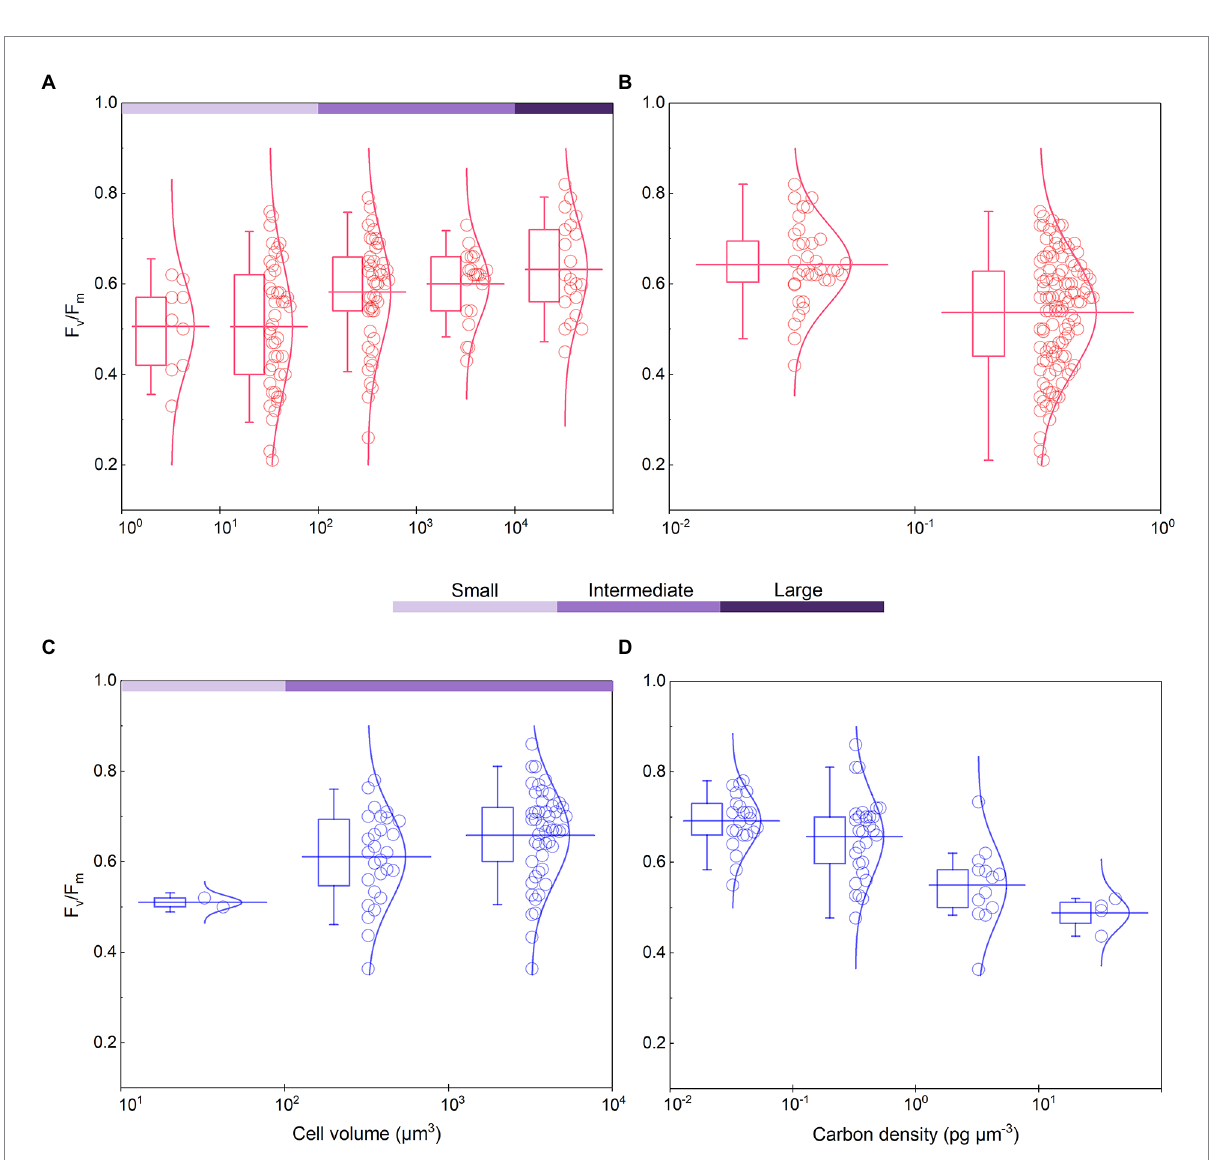
FIGURE 3 Algal F v / F m and carbon density in the normal culture experiment [ (A,B) , including the collected data] and field work (C,D) . The classification of cell volume is referred to the text, and carbon density is nominally distributed on a scale of 10. The curve represents the normal distribution of data. The box encompasses the 25–75th percentiles, and whiskers and midline are the standard deviation and mean, respectively.